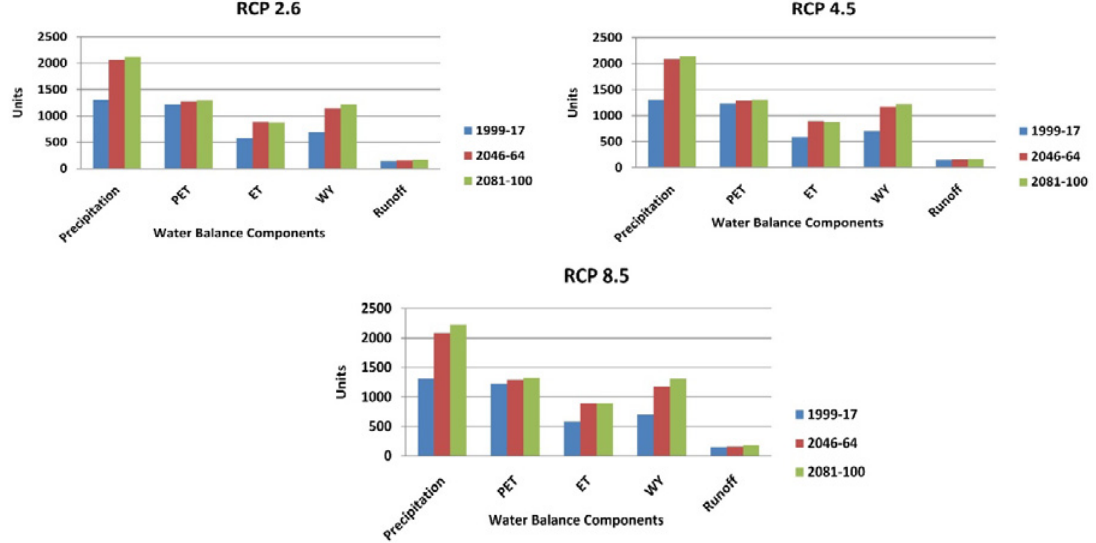
Fig. 7: Annual variation on different water balance components under different RCP scenarios